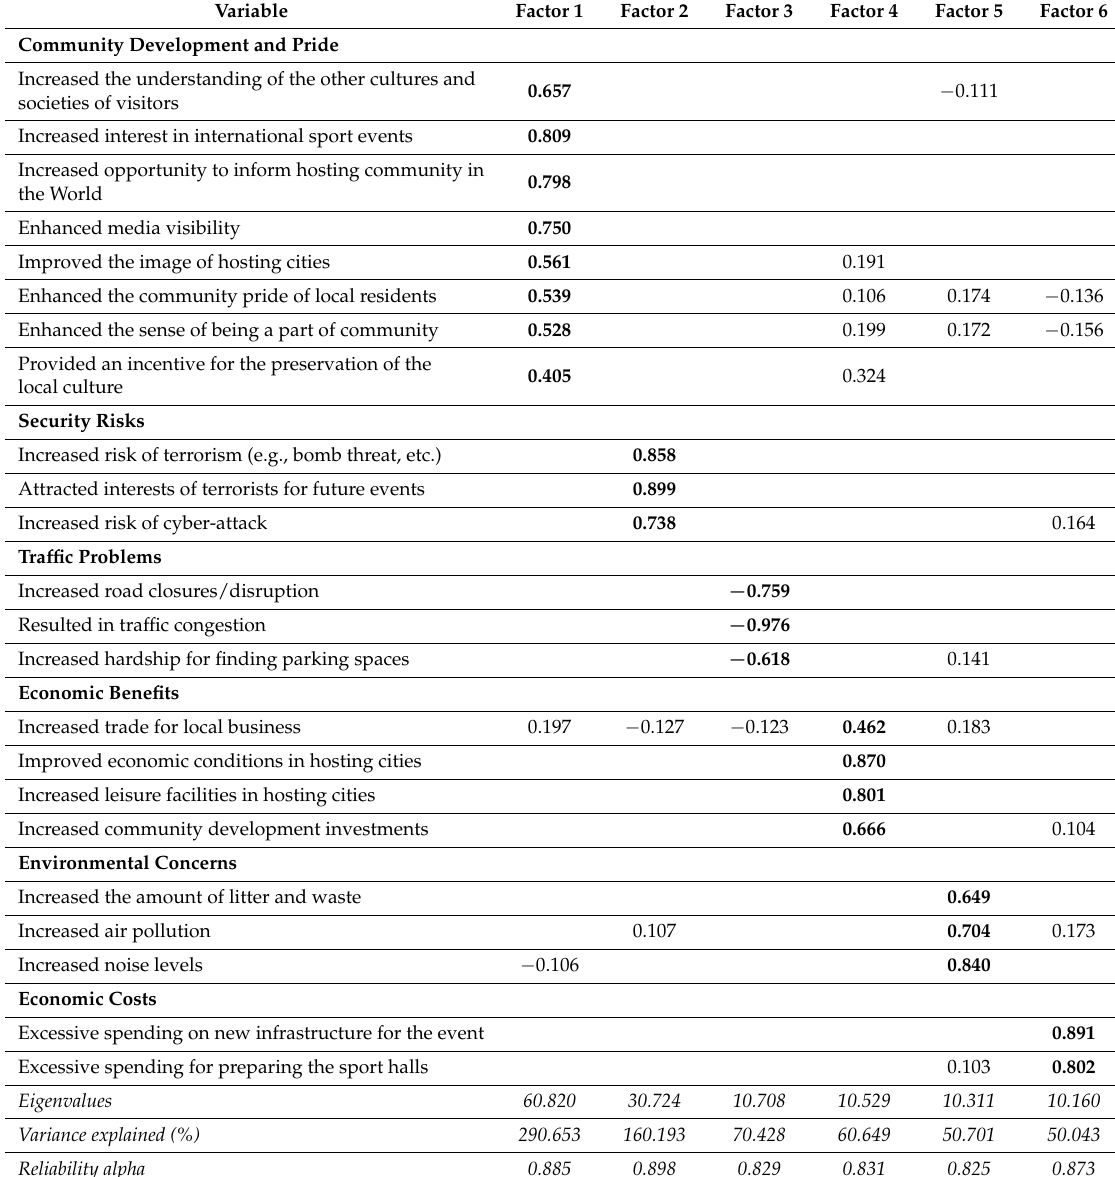
Table 3. Results of exploratory factor